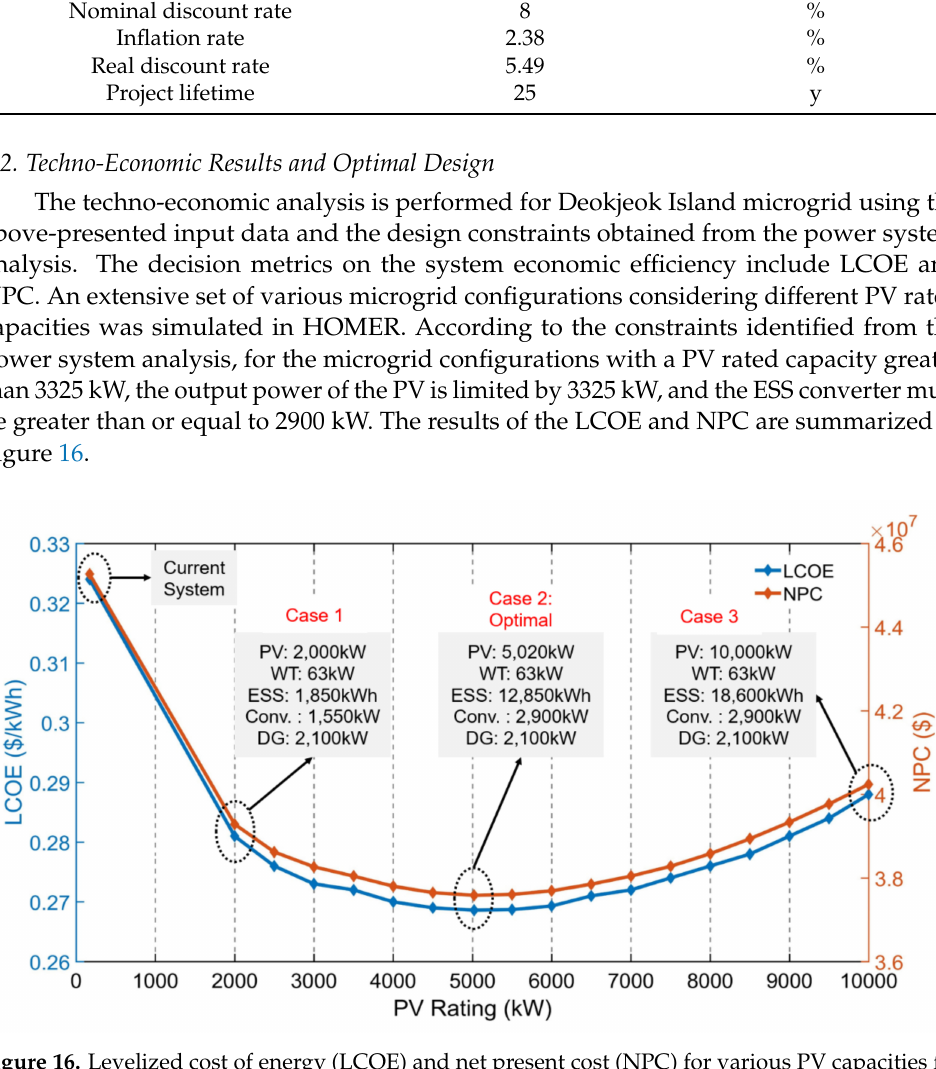
Figure 16. Levelized cost of energy (LCOE) and net present cost (NPC) for various PV capacities for Deokjeok Island